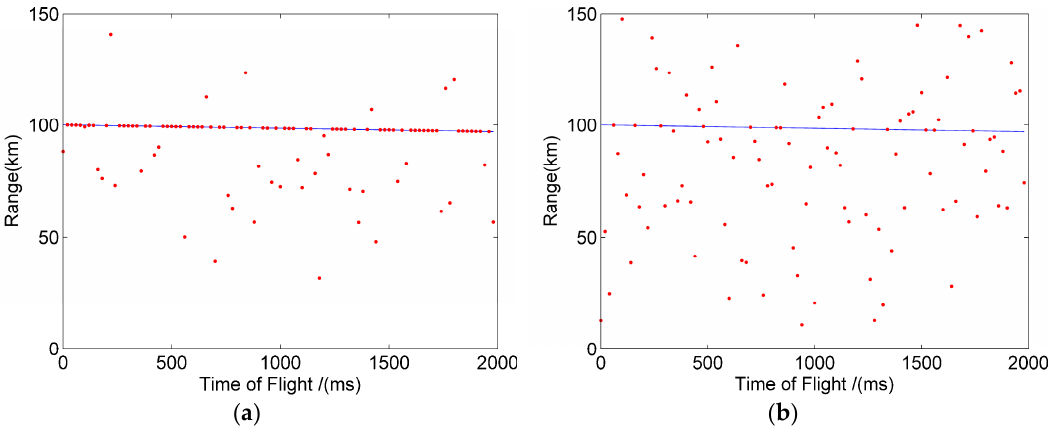
Figure 9. Target trajectory of experiment. ( a ) Macro pulse method. ( b ) Pulse accumulation method.